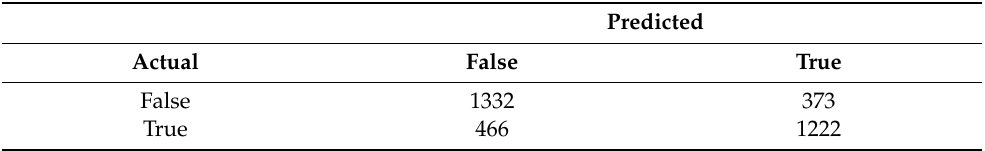
Table 2. Confusion matrix obtained on the test dataset with a threshold of 0.5 through the RF model optimized to detect observations higher than the median.